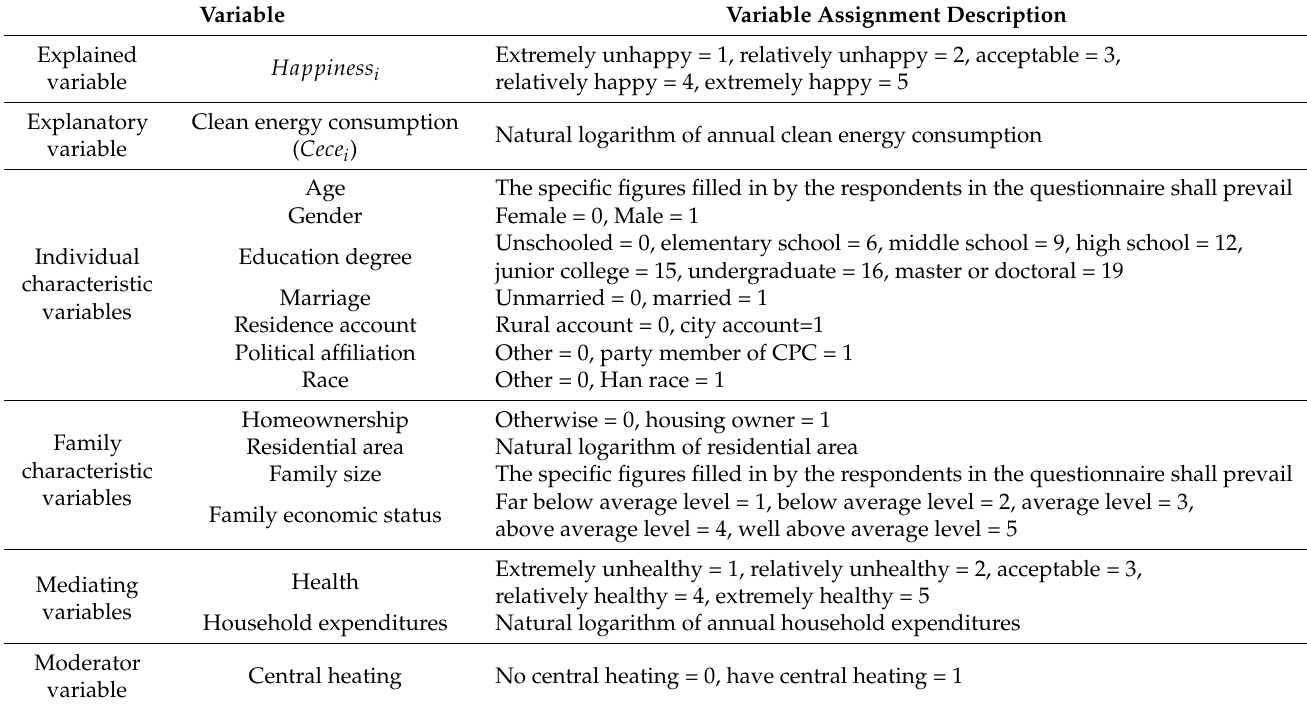
Table 1. Variable